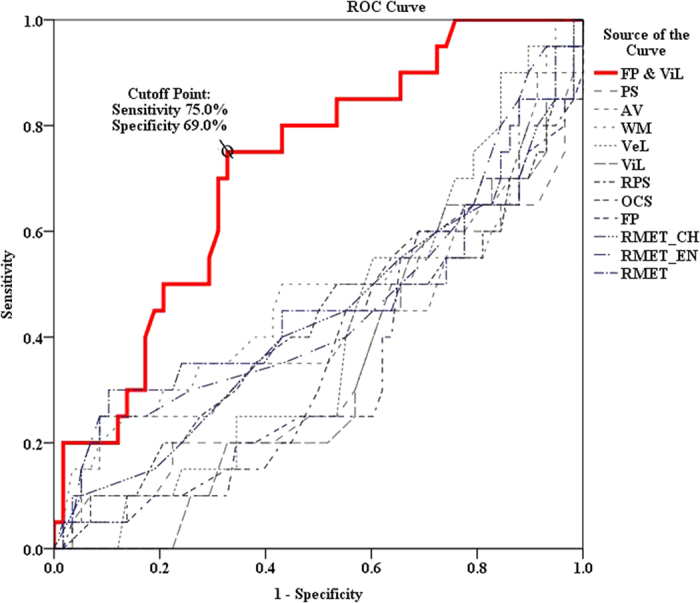
Receiver operating characteristic curves (ROC) of the combined FP-ViL index, compared to individual cognitive domain for predicting psychosis.